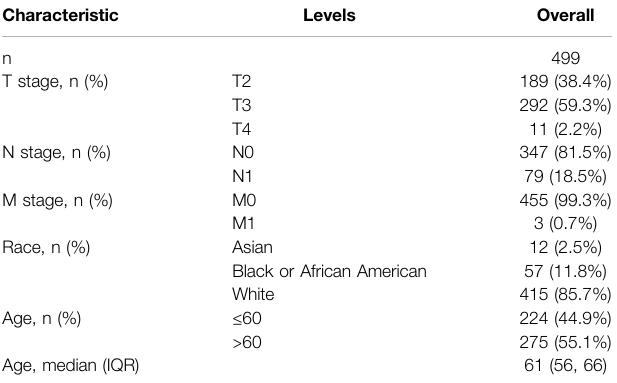
TABLE 1 | Basic clinical characteristics of PRAD patients in TCGA PRAD cohort. Characteristic Levels